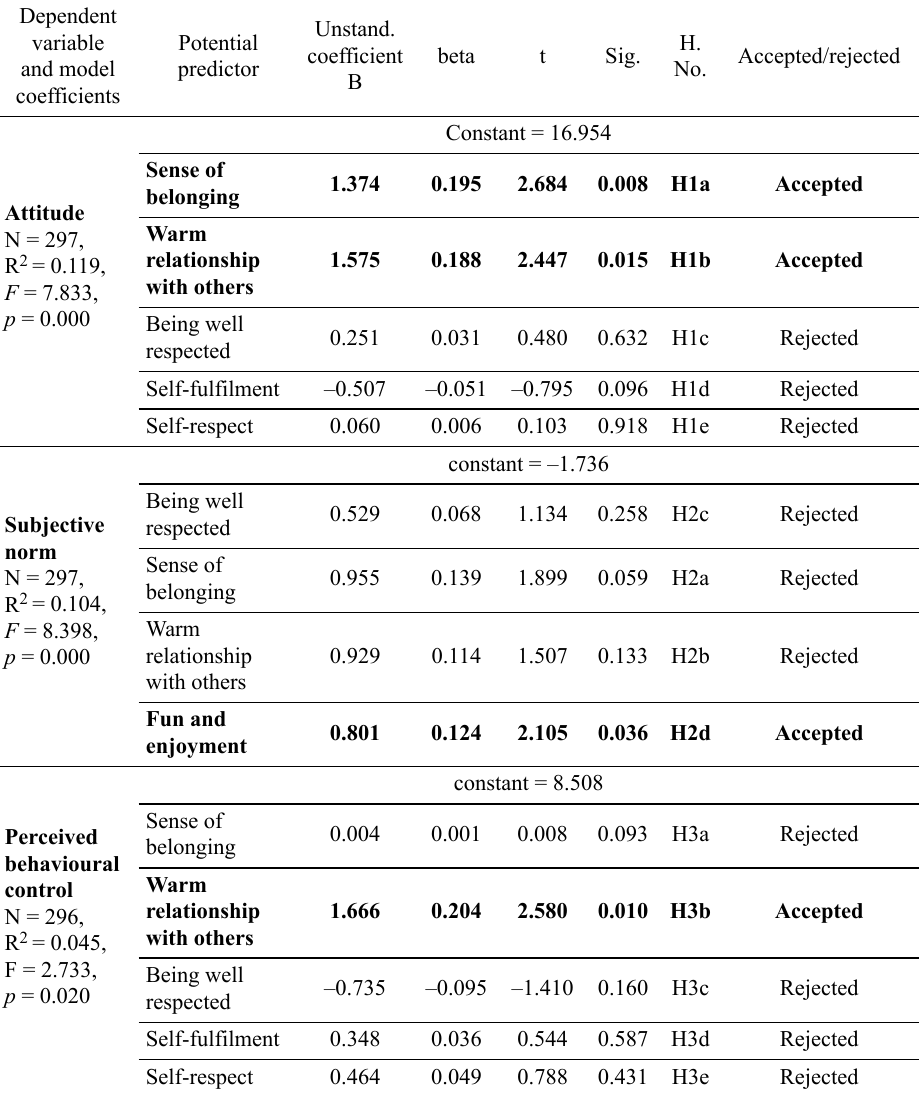
Table 7. Values as attitude, subjective norm and PBC predictors: summary of